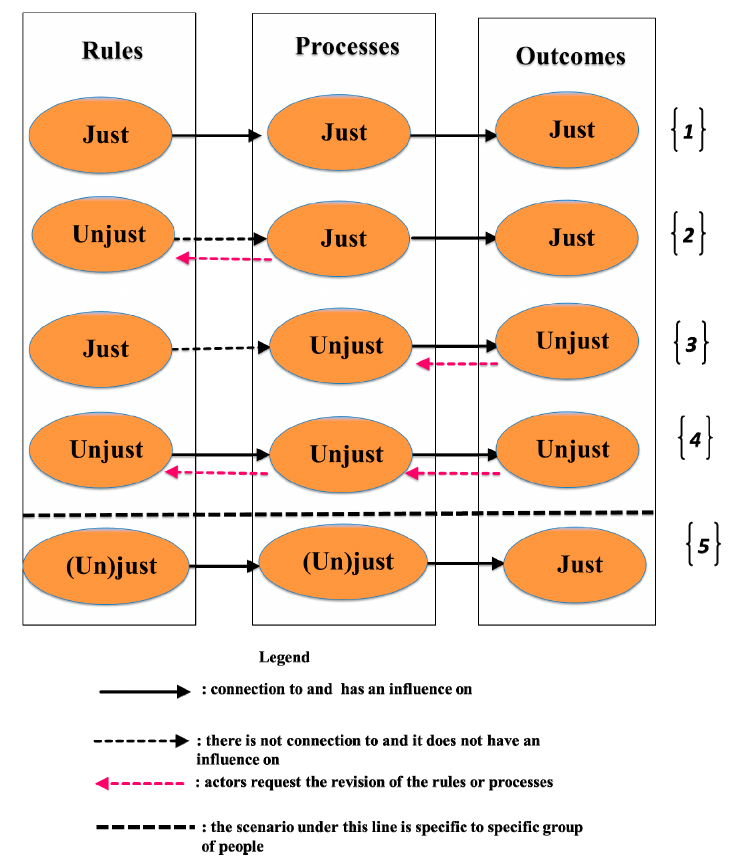
Figure 4. The matrix of the three dimensions of spatial justice. Developed based